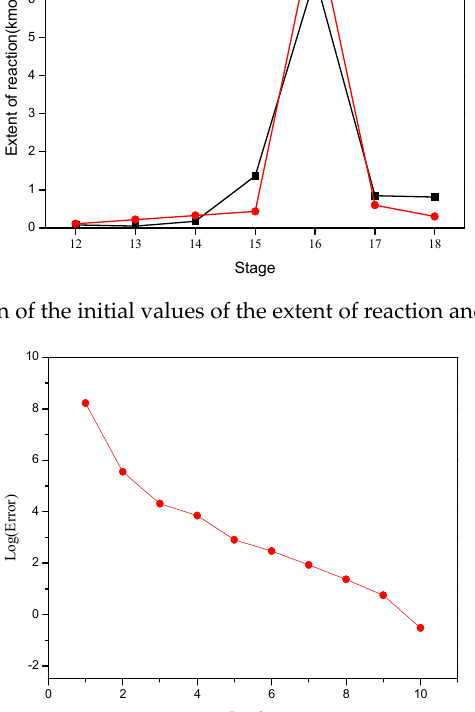
Figure 7. Error at each iteration for the simulation of isopropyl acetate reactive distillation column.